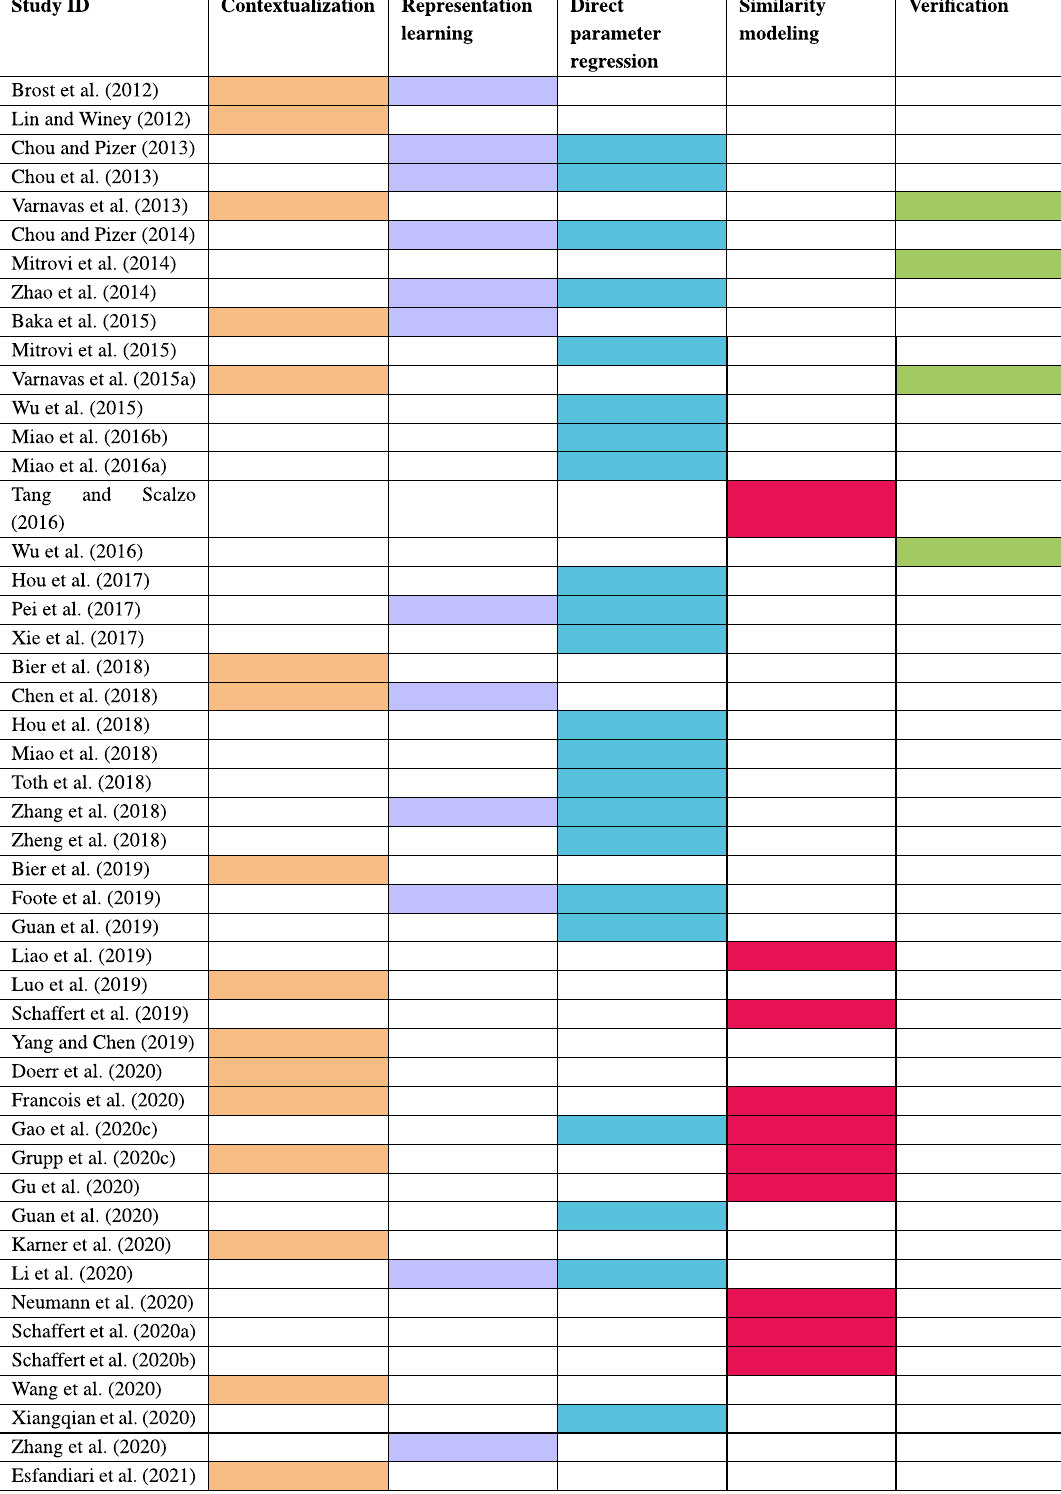
Frontiers in Robotics and AI |